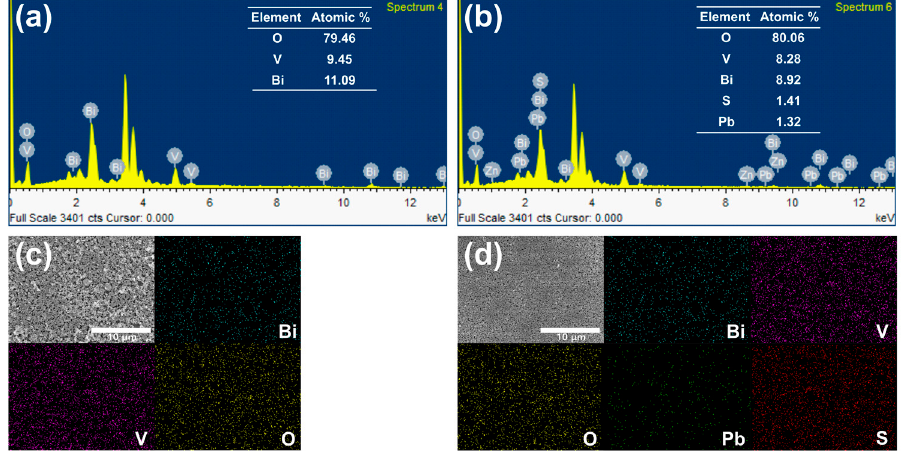
Figure 2. EDX spectra and mapping for each element (O, V, Bi, Pb, and S) of the surface of ( a , c ) bare BiVO 4 and ( b , d ) BiVO 4 /PbS QDs films on FTO glasses.